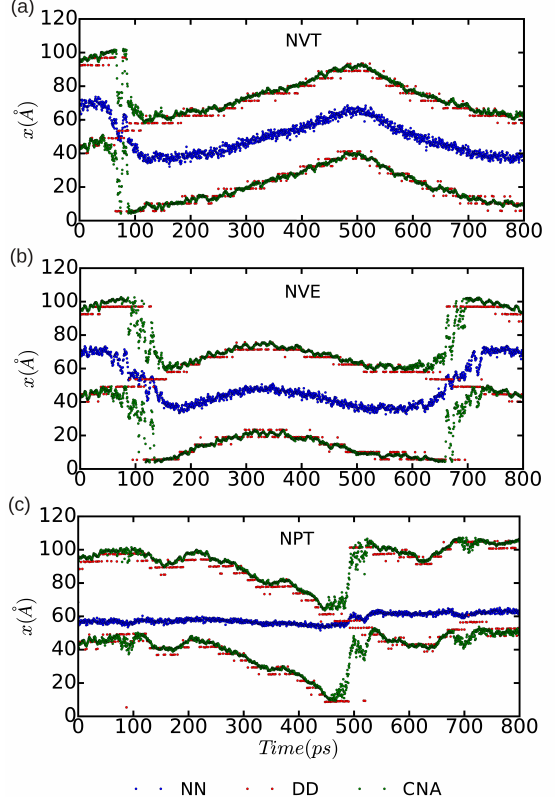
Figure 10. Position of the dissociated edge dislocation expressed as a function of time for a simulation cell containing n = 18,424 atoms. Molecular dynamics simulations have been performed in the three thermodynamic ensembles ( a ) NVT , ( b ) NVE , and ( c ) NPT ; the temperature has been fixed to 25 K, the pressure to zero, and the volume to the equilibrium one. In the NVE case, an equilibrium temperature of 12.5 K is reached. “DD”, “NN”, and “CNA” stand for the analysis methods of differential displacement, nearest neighbors, and common neighbor,